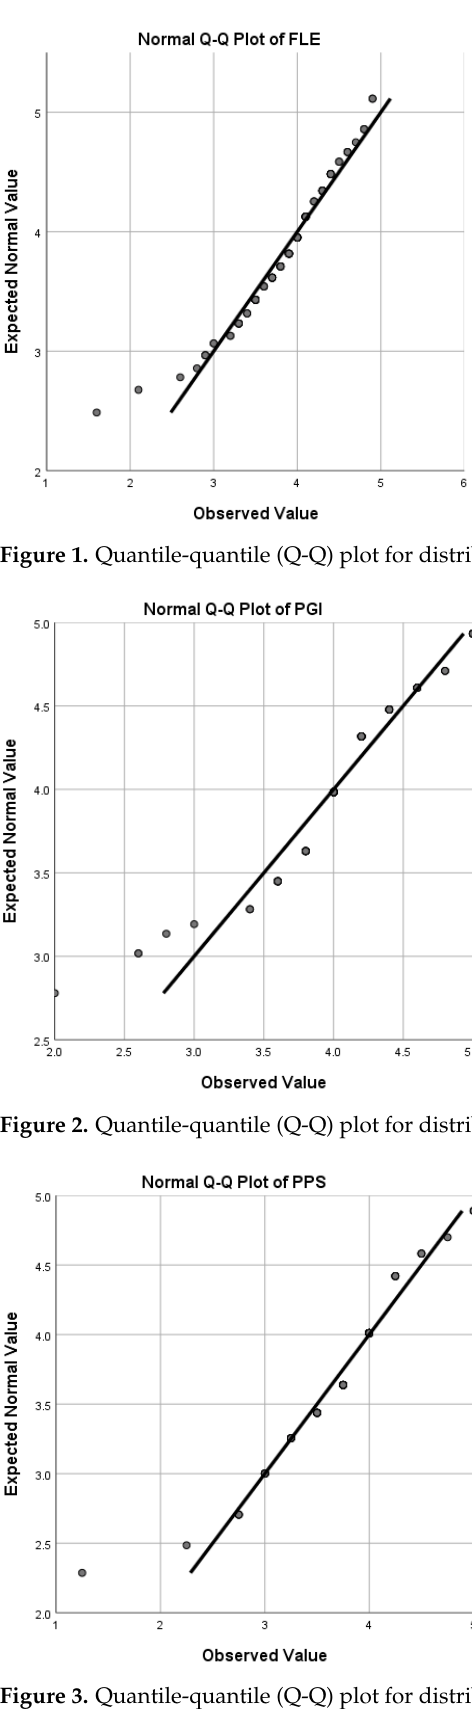
Figure 4. Quantile-quantile (Q-Q) plot for distribution of ER scores. 2.4. Data Analysis This study employed a cross-sectional, quantitative design. SPSS 26.0 was adopted to conduct data analysis in the present study. First, Harman’s single -factor test was per- formed to assess the common method bias. Second, the reliability of each scale used was tested by Cronbach’s Alpha and only those that sho wed good reliability were selected and used. Third, descriptive statistics were generated including mean and standard deviation. Fourth, Pearson’s correlation analysis was performed among all the variables to analyze the correlation between FLE and ER as well as between FLE and the factors which shape CL. Fifth, we ran multiple linear regression analysis to investigate and determine the pre- dictors of FLE.